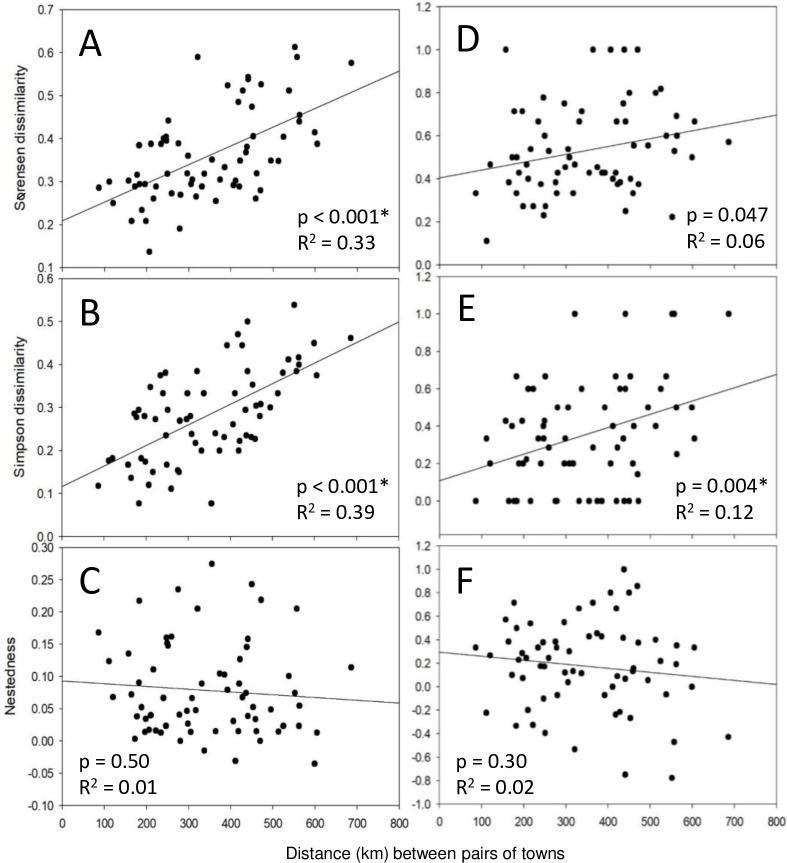
Relationships between dissimilarity indices and distance between pairs of towns (N = 66).A-C: All taxa identified to species. D-F: non-native taxa only. The Sørensen dissimilarity index (A, D), which is a presence-absence metric, is partitioned to Simpson’s dissimilarity index (a measure of species replacement; B, E) and nestedness (C, F). Regression p and R2 values are given on each graph. A Bonferroni-corrected α = 0.025 was used to adjust for using two sets of related data (total and non-native). Significant p-values are denoted by ‘*’.